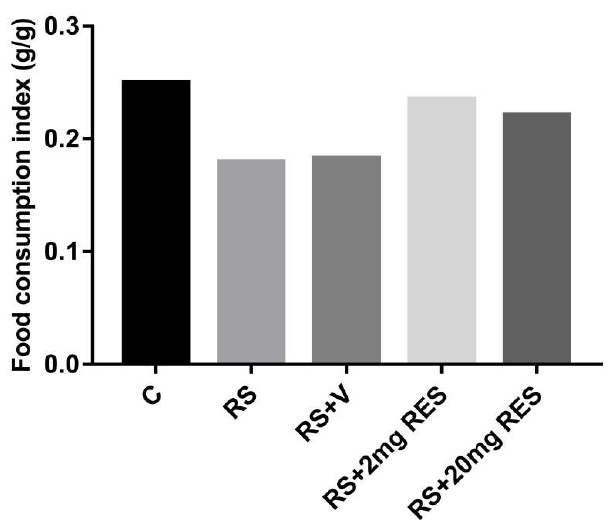
Figure 2. Effects of resveratrol on food consumption index of non-stressed mice (C), restraint-stressed mice (RS), restraint-stressed mice treated with vehicle (RS + V), restraint-stressed mice treated with 2 mg/kg body weight of resveratrol (RS + 2 mg RES), and restraint-stressed mice treated with 20 mg/kg body weight of resveratrol (RS + 20 mg RES). The columns represent the average food consumption index during the 15-day treatment. Food consumption index (g/g) = total food consumed per day/total body weight.